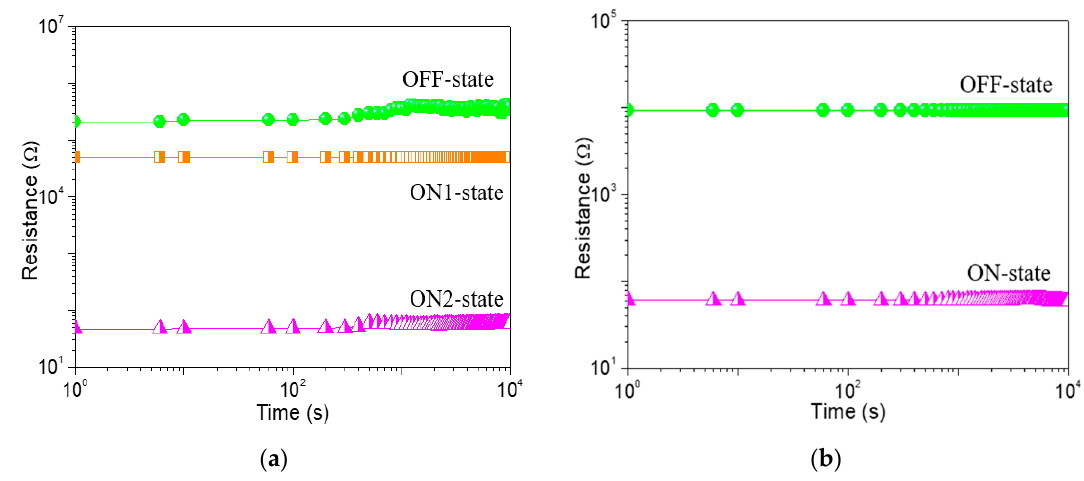
Figure 7. Retention property of ( a ) ITO/GO:0.5 wt%GQDs/Ni device and ( b ) ITO/GO/Ni. The resistance value was read at a constant voltage of − 0.1